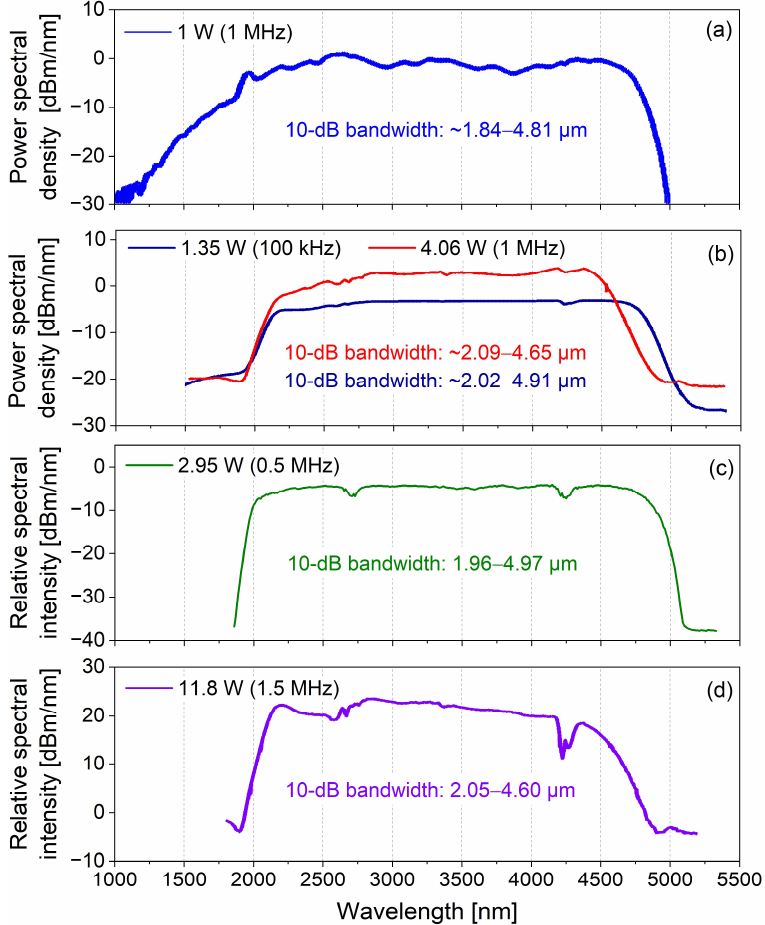
Figure 9. SC spectra generated from fluoroindate fibers, recorded for different average output powers: 1 W ( a ), 1.35 and 4.06 W ( b ), 2.95 W ( c ), and 11.8 W ( d ). Corresponding pulse repetition frequencies are shown in parentheses. ( a ) Reproduced with permission from [59], Copyright 2018, Reproduced from [77]. ( d ) Reproduced under the terms of the Creative Commons BY license [61].